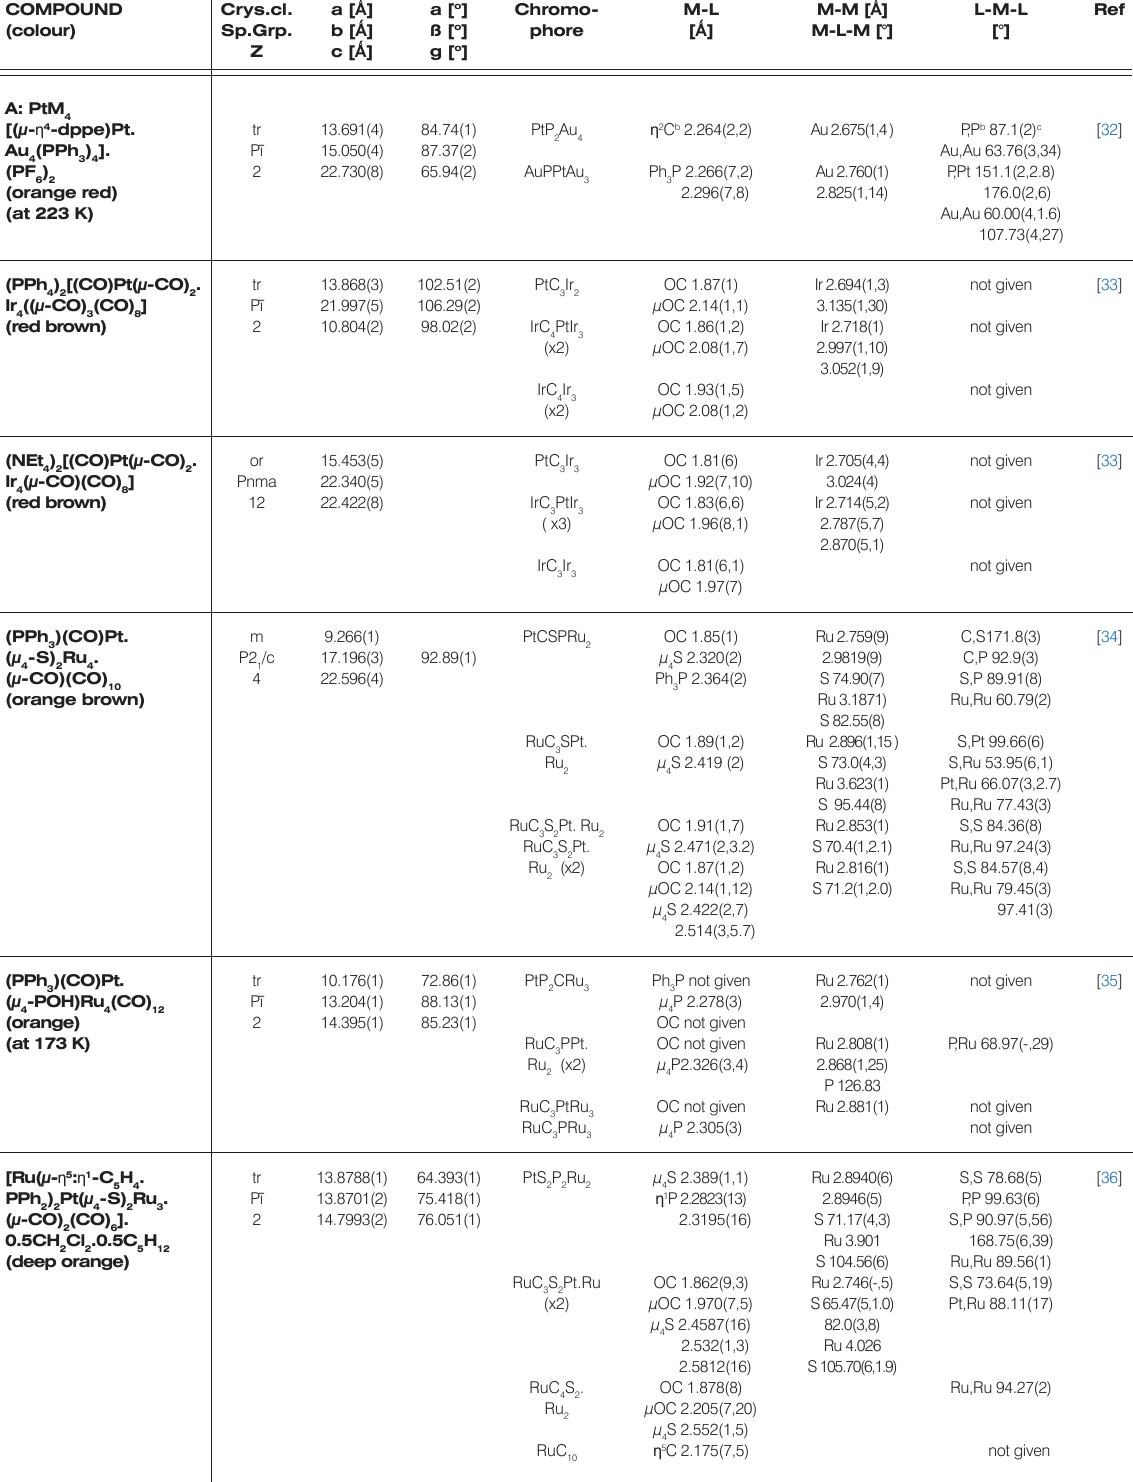
, Pt MM’, Pt M M’, Pt M M ’ and PtM 4 3 2 2 2 2 2